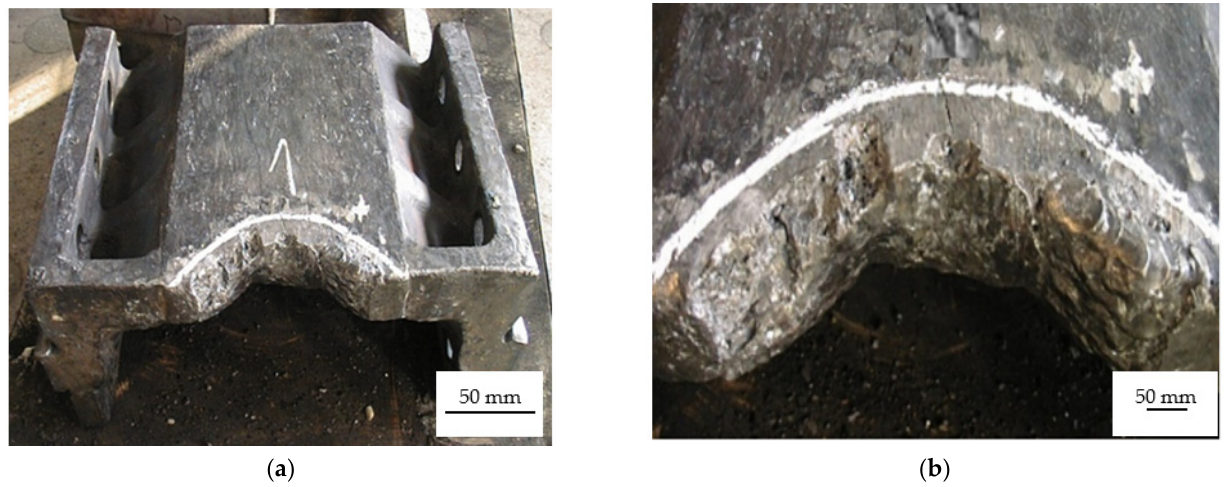
Figure 4. Wear of the active parts of the half-trimming dies: ( a )—accentuated wear, disposed approximately symmetrical on the entire length of the active part; ( b )—accentuated asymmetrical wear.